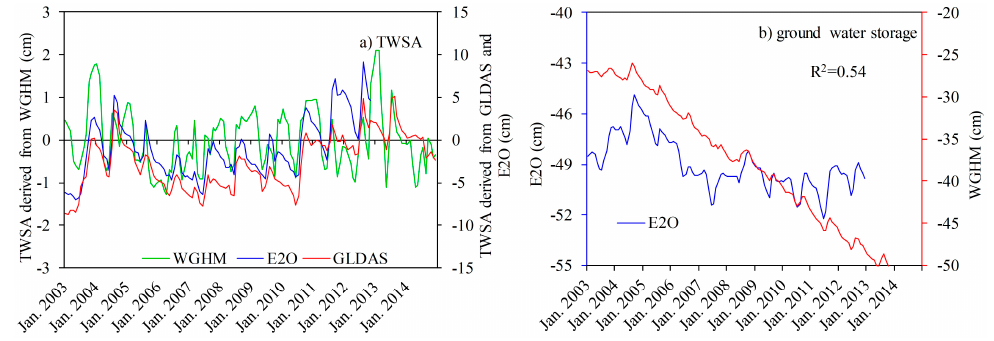
Figure 2. Evaluation of TWSA and GWS derived from GLDAS and E2O, respectively. ( a ) evaluation of TWSA derived from GLDAS with that derived from WGHM and E2O; ( b ) evaluation of GWS derived from E2O with that derived from WGHM.